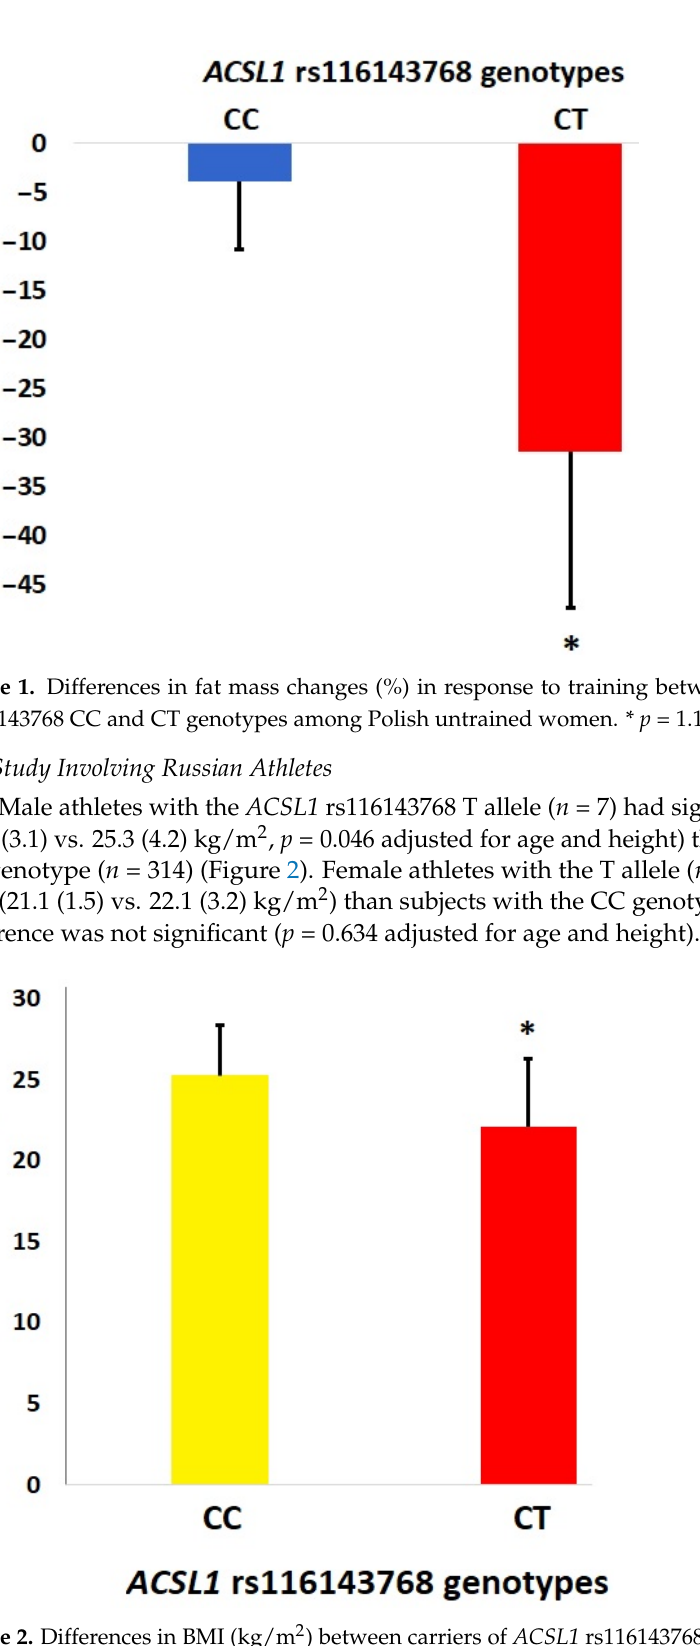
Figure 2. Differences in BMI (kg/m 2 ) between carriers of ACSL1 rs116143768 CC and CT genotypes among Russian athletes. * p = 0.046 (adj. for age and height).